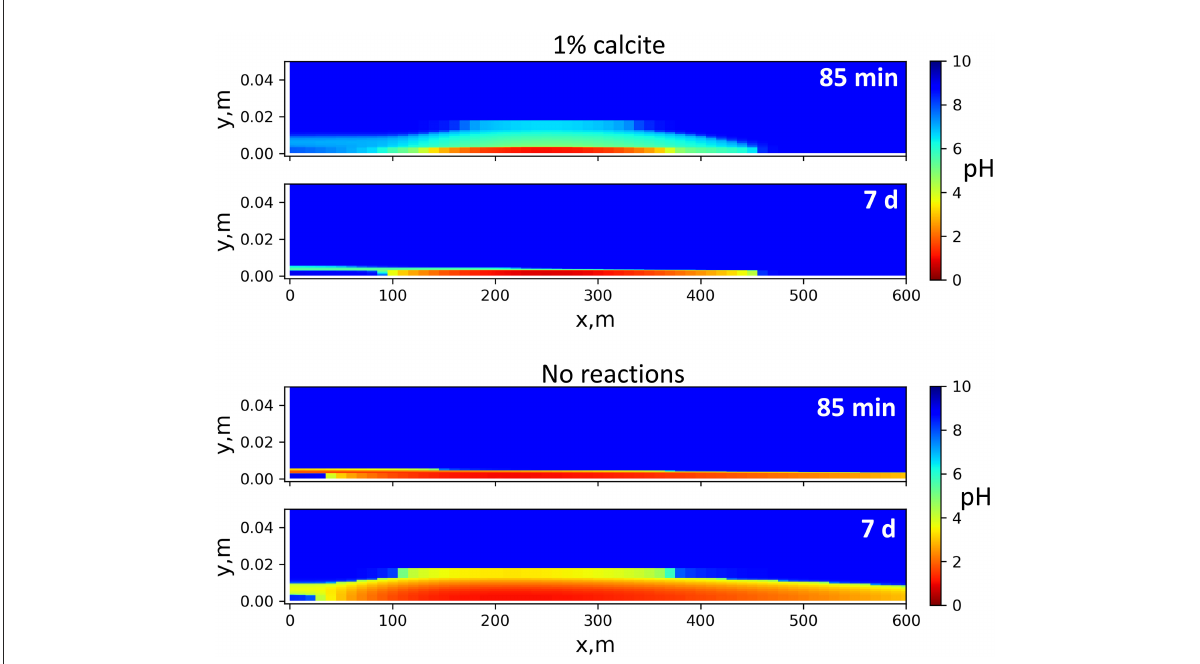
FIGURE6 pH distribution in the 2D flow-through sequential model assuming either 1 vol% calcite (Top) or no mineral reactions (Bottom) . With low calcite in shale, acid neutralization is slower. If no mineral reactions are considered, the acid quickly spreads over the entire main fracture length and slowly diffuses into the shale matrix through pore